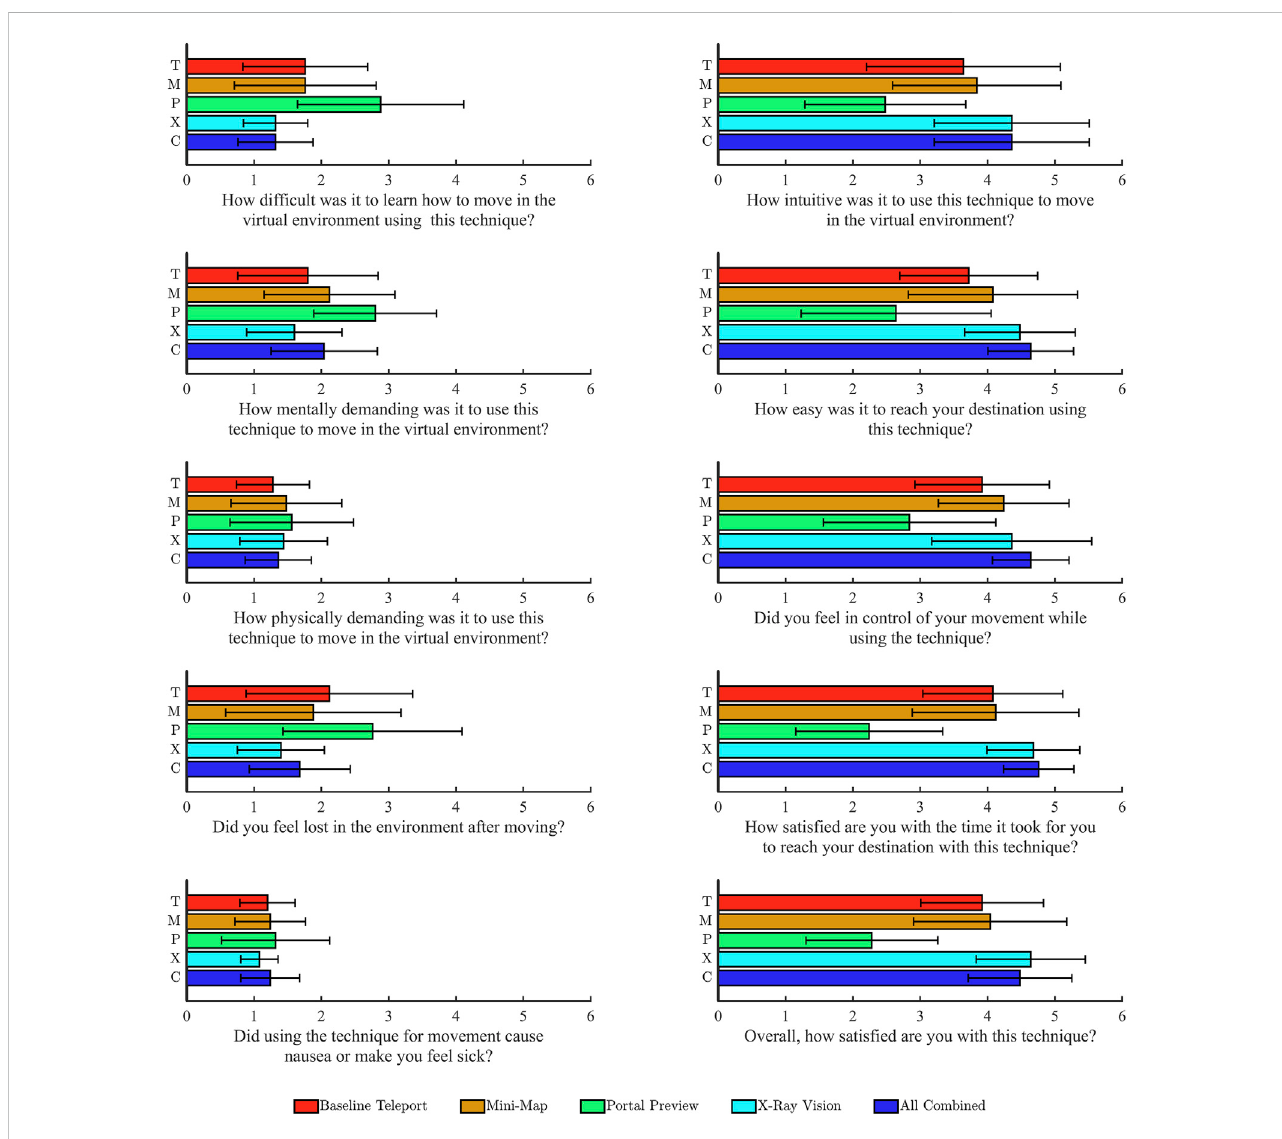
FIGURE 8 The average value of different subjective metrics along with standard deviation